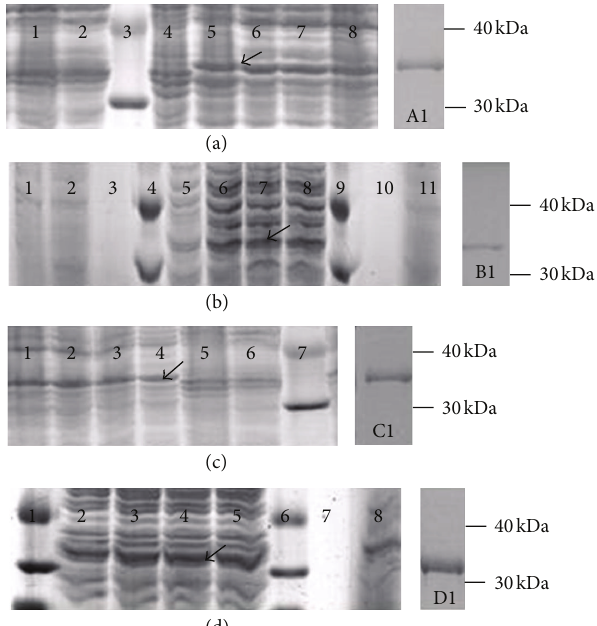
Figure 2: SDS-PAGE analysis of four different recombinant chitinases. (a) Intracellular recombinant chitinase inrCHI31; 1: control transformantBL21-pET52b;2:controltransformantBL21-pET52binducedby1.0 mMIPTG;3:proteinmarker;4:transformantBL21-inCHI31; 5–8: transformant BL21-inCHI31 induced by 1.0mM IPTG for 3, 4, 5, and 6h. (b) Extracellular recombinant chitinase exrCHI31; 1–3: control transformant BL21-pET52b induced by 1.0mM IPTG for 3, 6, and 0h; 4, 9: protein marker; 5–8: transformant BL21-exCHI31 induced by IPTG for 3, 4, 5, and 6h; 10-11: transformant BL21-exCHI31 was not induced. (c) Intracellular recombinant chitinase inrCHI32; 1–5: transformant BL21-inCHI32 induced by 1.0mM IPTG for 6, 5, 4, 3, and 0h; 6: control transformant BL21-pET52b induced by 1.0 mM IPTG for 5h; 7: protein marker. (d) Extracellular recombinant chitinase exrCHI32. 1: protein marker; 2–5: transformant BL21-exCHI32 induced by